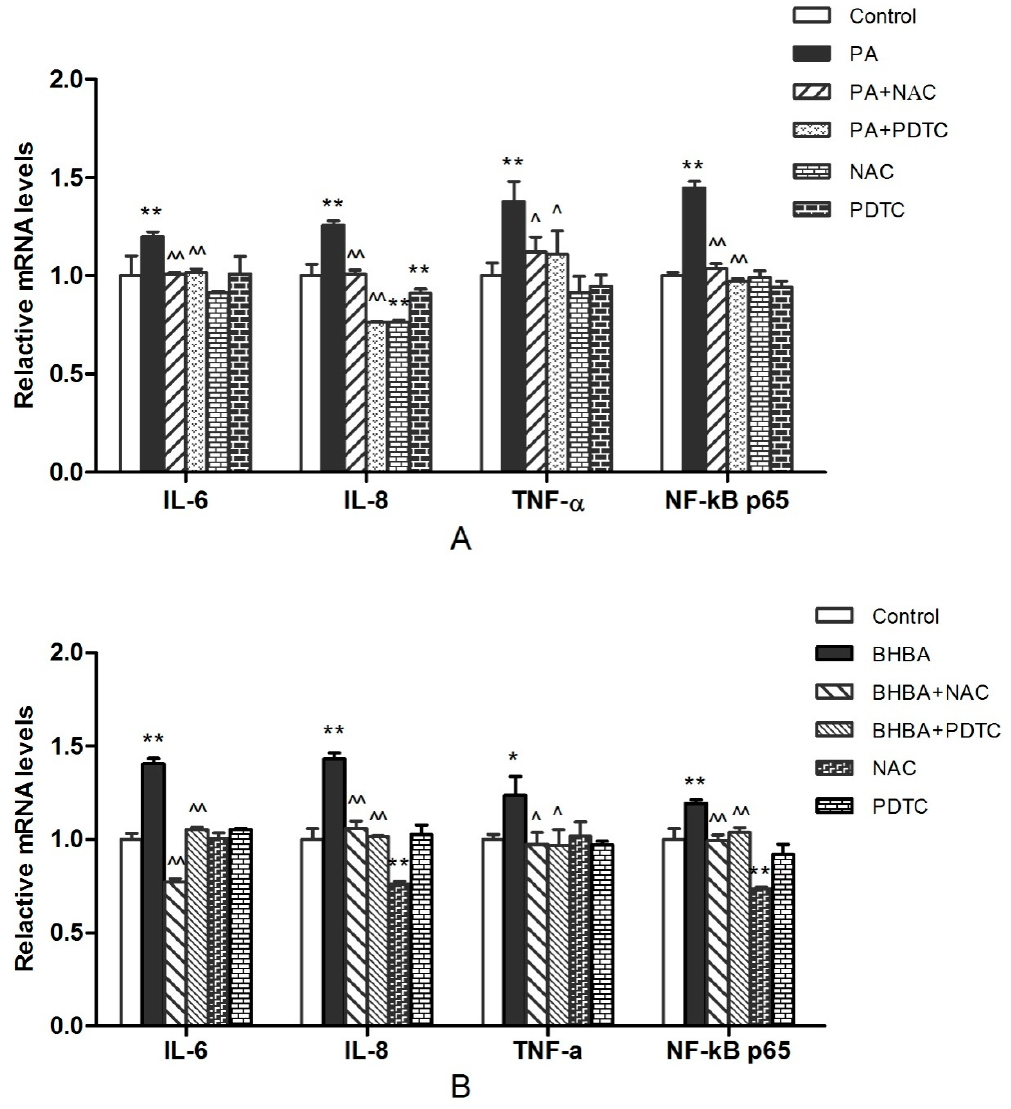
Figure 3. RT-PCR analysis of related gene expression. ( A ) BEND cells were treated with 0.6 mM PA, 0.6 mM PA + 10 mM NAC (PA + NAC), 0.6 mM PA + 10 µ M PDTC (PA + PDTC), 10 mM NAC, or 10 µ M PDTC for 24 h. ( B ) BEND cells were treated with 2.4 mM BHBA, 2.4 mM BHBA + 10 mM NAC (BHBA + NAC), 2.4 mM BHBA + 10 µ M PDTC (BHBA + PDTC), 10 mM NAC, or 10 µ M PDTC for 24 h. Data are expressed as the mean ± SEM. * P < 0.05, ** P < 0.01 vs. the control group; ˆ P < 0.05, ˆˆ P < 0.01 vs. the PA or BHBA group.